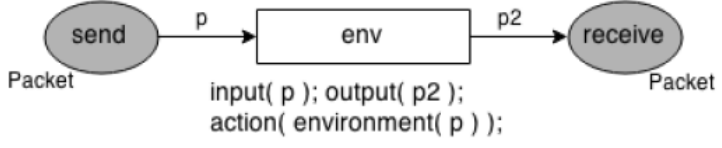
Figure 7. Environment